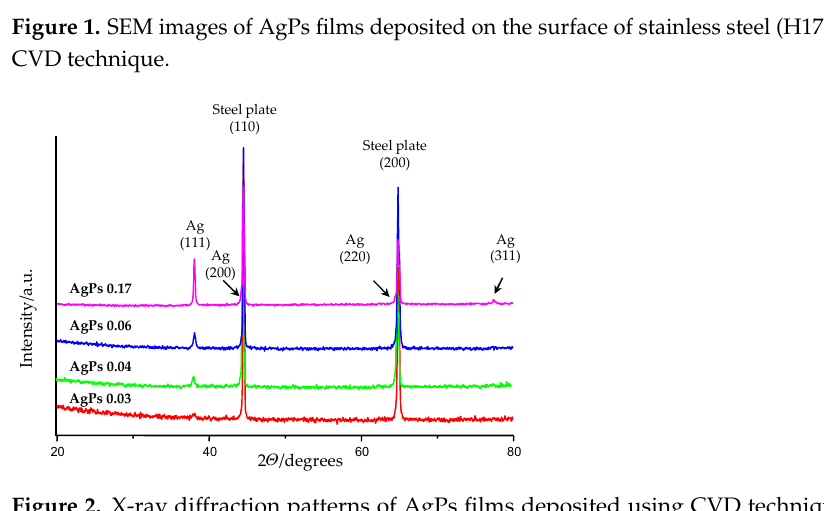
Figure 2. X-ray diffraction patterns of AgPs films deposited using CVD technique. A number of Bragg reflection peaks were observed at 2 θ values of 38.2°, 44.3°, 64.3° and 77.6°, which are indexed to (111), (200), (220) and (311), respectively. 3.2. LDI-MS Performances of Silver Nanostructures for Low Molecular Weight Biomolecules According to obtained results (Figure 3), all of the synthesized plates showed sensi- tivity to various low molecular weight compounds in both ion-positive and ion-negative